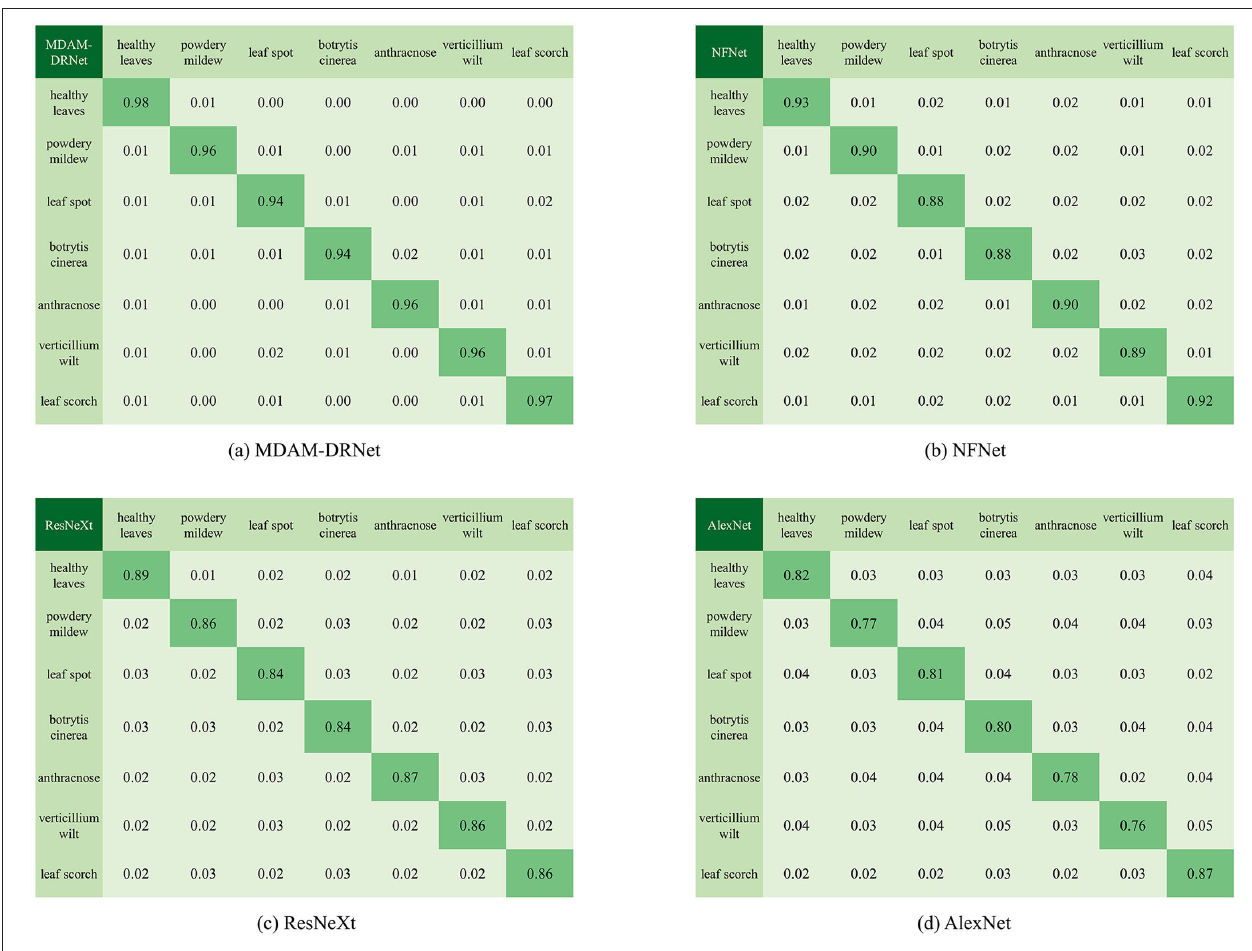
FIGURE 12 | Confusion matrix corresponding to MDAM-DRNet, B-ARNet, ResNeXt, and CNN models.